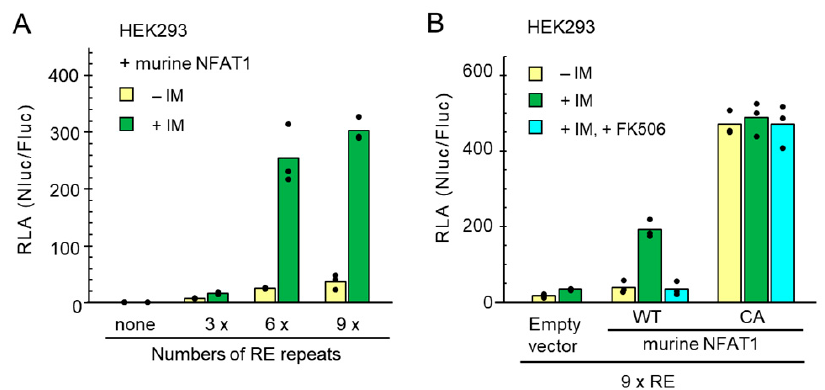
Figure 2. Evaluation of the NanoLuc reporter system by expressing murine NFAT1. ( A ) HEK293 cells were co-transfected with an expression vector of murine NFAT1, a firefly luciferase (Fluc) expression plasmid (pGL4.53[ luc2/ PGK]), and pNL3.2[ NlucP/ minP] containing different numbers (none, 3, 6 and 9) of the IL8 NFAT-RE. One day after transfection, cells were stimulated with ionomycin (IM, 1 μ M; vehicle, 0.007% ethanol) for 6 h. Cell lysates were used to measure luminescent signals of NanoLuc (Nluc) and Fluc using a Nano-Glo Dual-Luciferase Reporter Assay System. The ratio of Nluc to Fluc, Nluc/Fluc, is expressed as normalized relative luciferase activity (RLA). Dots and bars represent individual and averaged RLA values obtained from triplicate assays, respectively. ( B ) HEK293 cells were co-transfected with expression plasmids for NanoLuc reporter and Fluc together with either wild type (WT), constitutively active type (CA) murine NFAT1 or empty vector (pcDNA3). One day after transfection, cells were pre-treated with FK506 (10 μ M) or vehicle (0.16% ethanol) for 1 h and then subjected to ionomycin (IM) stimulation for 6 h, followed by luciferase assays.